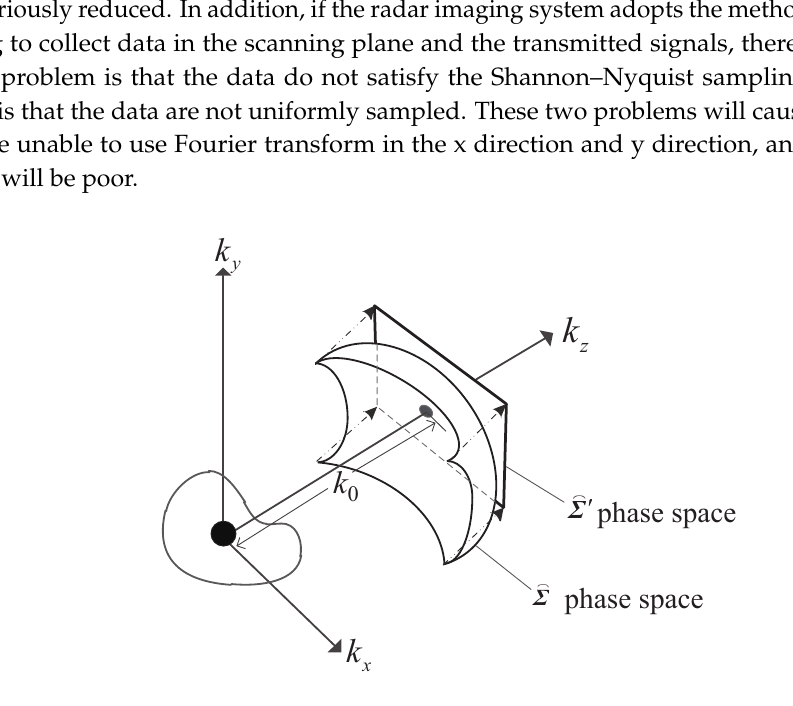
Figure 2. Schematic diagram of wavefront